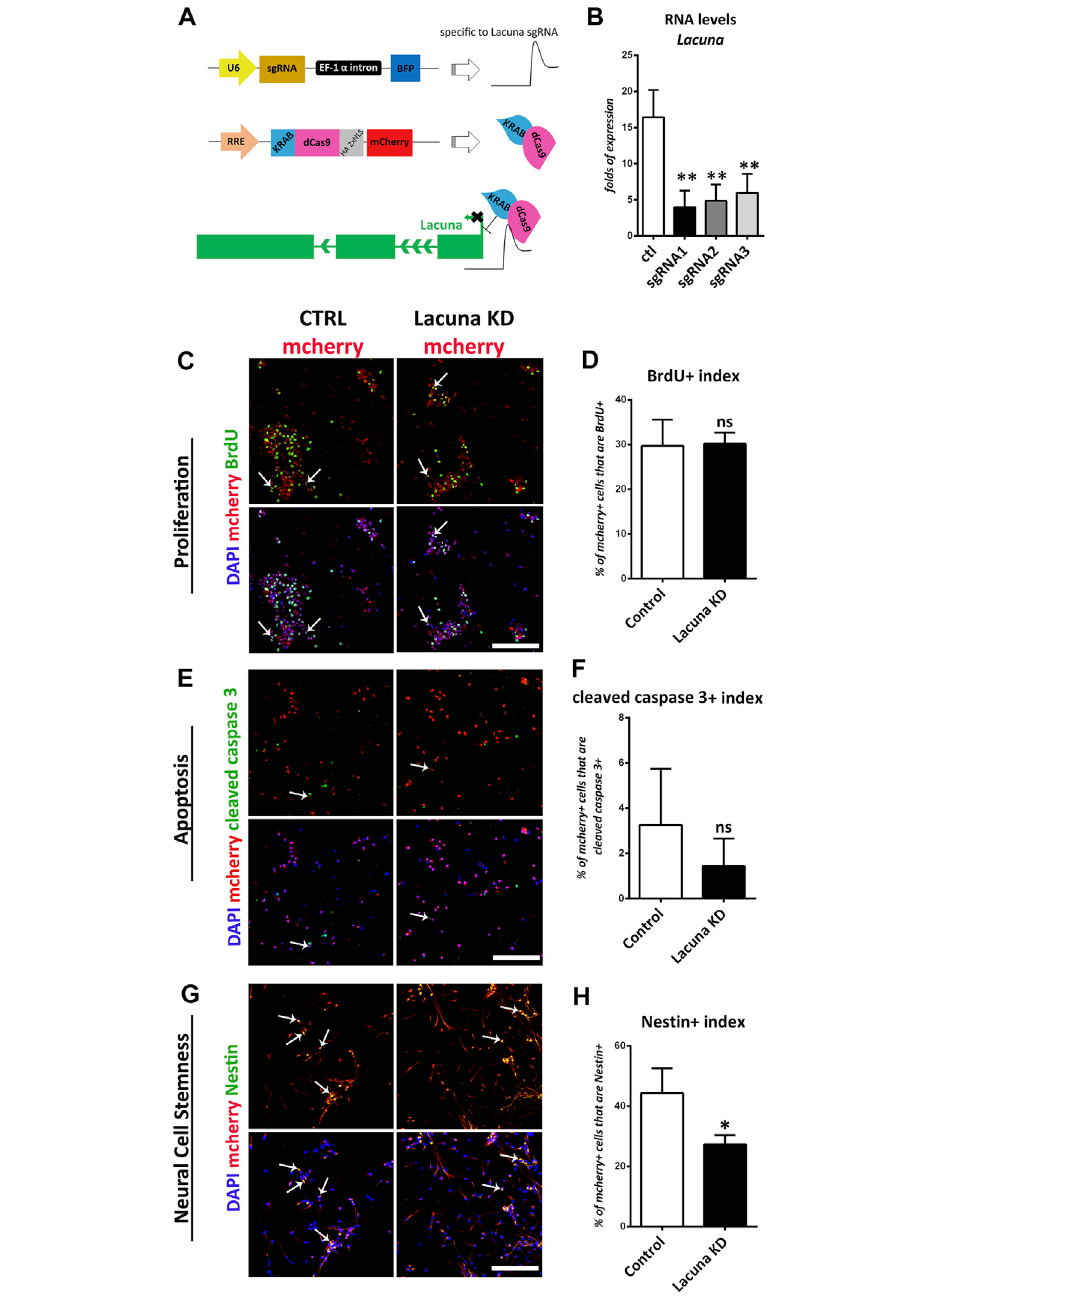
FIGURE 4 | Lacuna knockdown reduces stemness but does not affect proliferation nor apoptosis of mouse Neural Stem Cells. (A) Scheme of dCas9-KRAB effector system and Lacuna knockdown strategy. The fi rst plasmid expresses the guide RNAs that target Lacuna , the second plasmid expresses dCas9-KRAB and mcherry. When transfected together in Neural Stem cells, guide RNA recruits dCas9-KRAB fusion protein to Lacuna and inhibits its expression. In control cultures, NSCs weretransfectedwithboth plasmids,but fi rstplasmidlackedaguideRNAsequence. (B) ThreedifferentguideRNAsequenceswereusedtotarget Lacuna gene. All constructs were ef fi cient in knocking down Lacuna expression. We selected sgRNA1 to proceed further. (C) Mouse Neural Stem cells were transfected with dCas9-KRAB-mcherry and sgRNA1 targeting Lacuna ( Lacuna KD-mcherry) or no guide RNA (CTRL-mcherry). They were treated with BrdU for 2 h and then fi xed and stained with anti-BrdU antibody (green), anti-mcherry (red) and 4, 6-diamidino-2-phenylindole (DAPI). Scale bar: 100 μ m. (D) Quanti fi cation of BrdU incorporation in dCas9-KRAB-mcherrypositive mouse NeuralStem cells (Control: 29.67 ± 2.63%, Lacuna KD:30.18 ± 1.115%, p > 0.05, N (cid:2) 5independent experiments, in total 369 cellsforControlconditionand469cellsfor Lacuna condition). (E) MouseNeuralStemcellsweretransfectedwithdCas9-KRAB-mcherryandsgRNA1targeting Lacuna ( Lacuna KD-mcherry) or no guide RNA (CTRL-mcherry). They were immunostained for cleaved caspase 3 (green), mcherry (red) and labeled with DAPI. Scale bar: 100 μ m. (F) Quanti fi cation of cleaved caspase 3 positive cells in dCas9-KRAB-mcherry positive mouse Neural Stem cells (Control: 3.261 ± 1.013%, Lacuna KD: